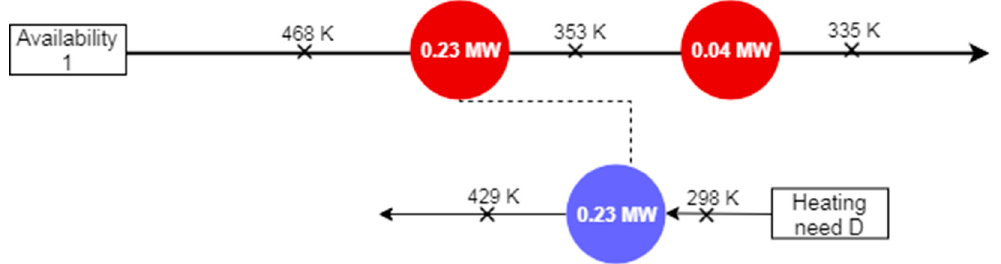
Figure 18. Combustion air preheating assessment.